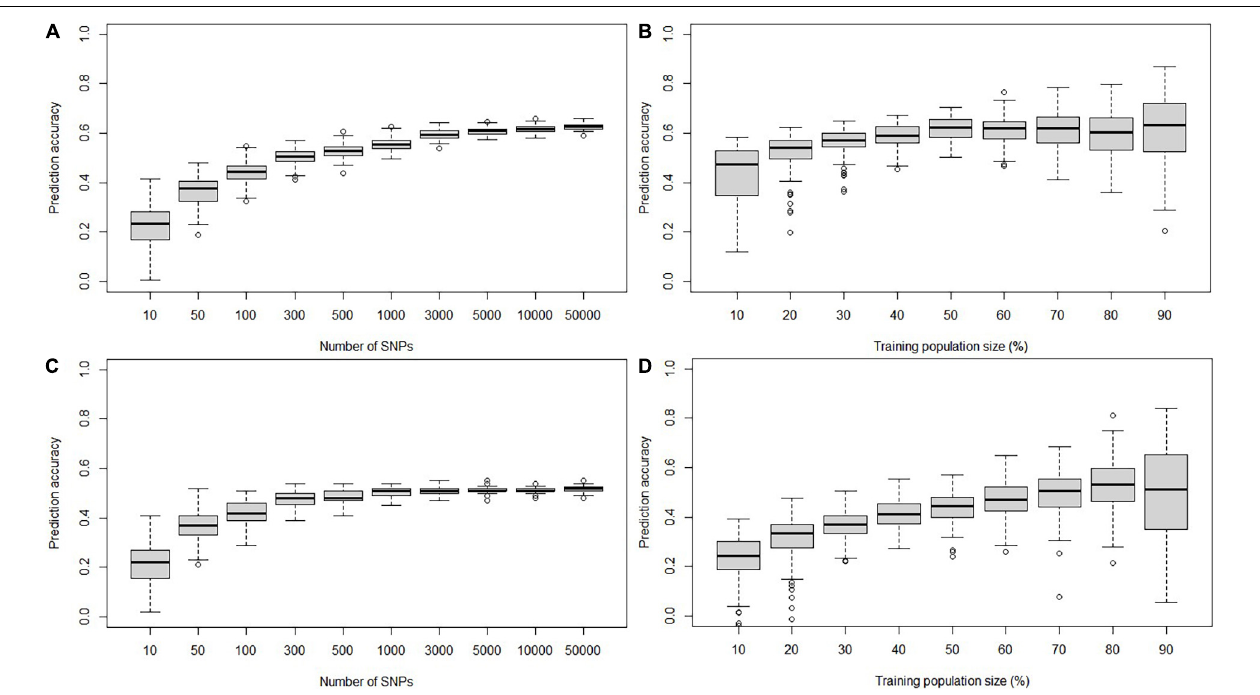
FIGURE 4 | Genomic prediction accuracy of common rust resistance in the DTMA panel and DH1 population, when the number of SNPs varied from 100 to 50,000 and training population size (TPS) ranged from 10 to 90% of the total population size. (A) In the DTMA panel estimated with different marker density, (B) in the DTMA panel estimated with different TPS, (C) in the DH1 population estimated with different marker density, and (D) in the DH1 population estimated with different